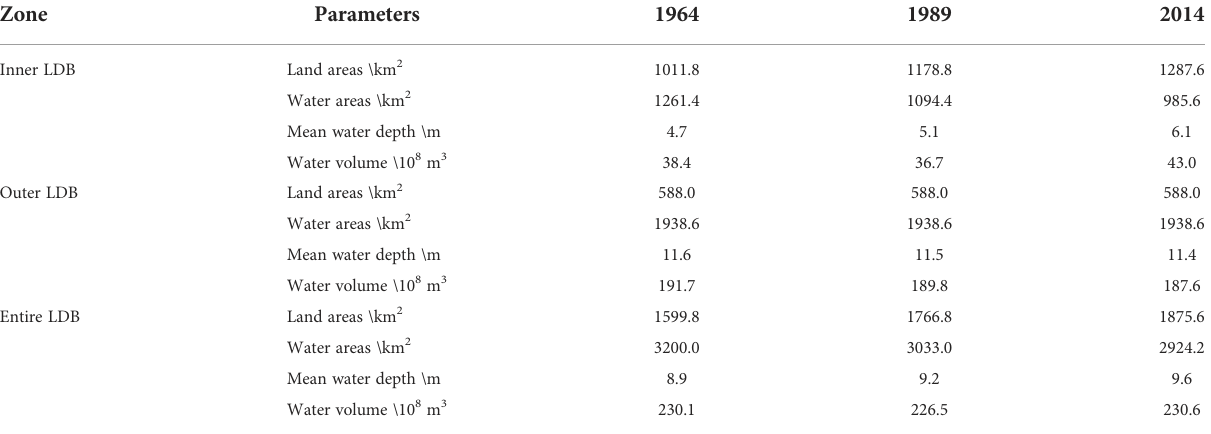
TABLE 1 Geometric characteristics observed in LDB from 1964 to